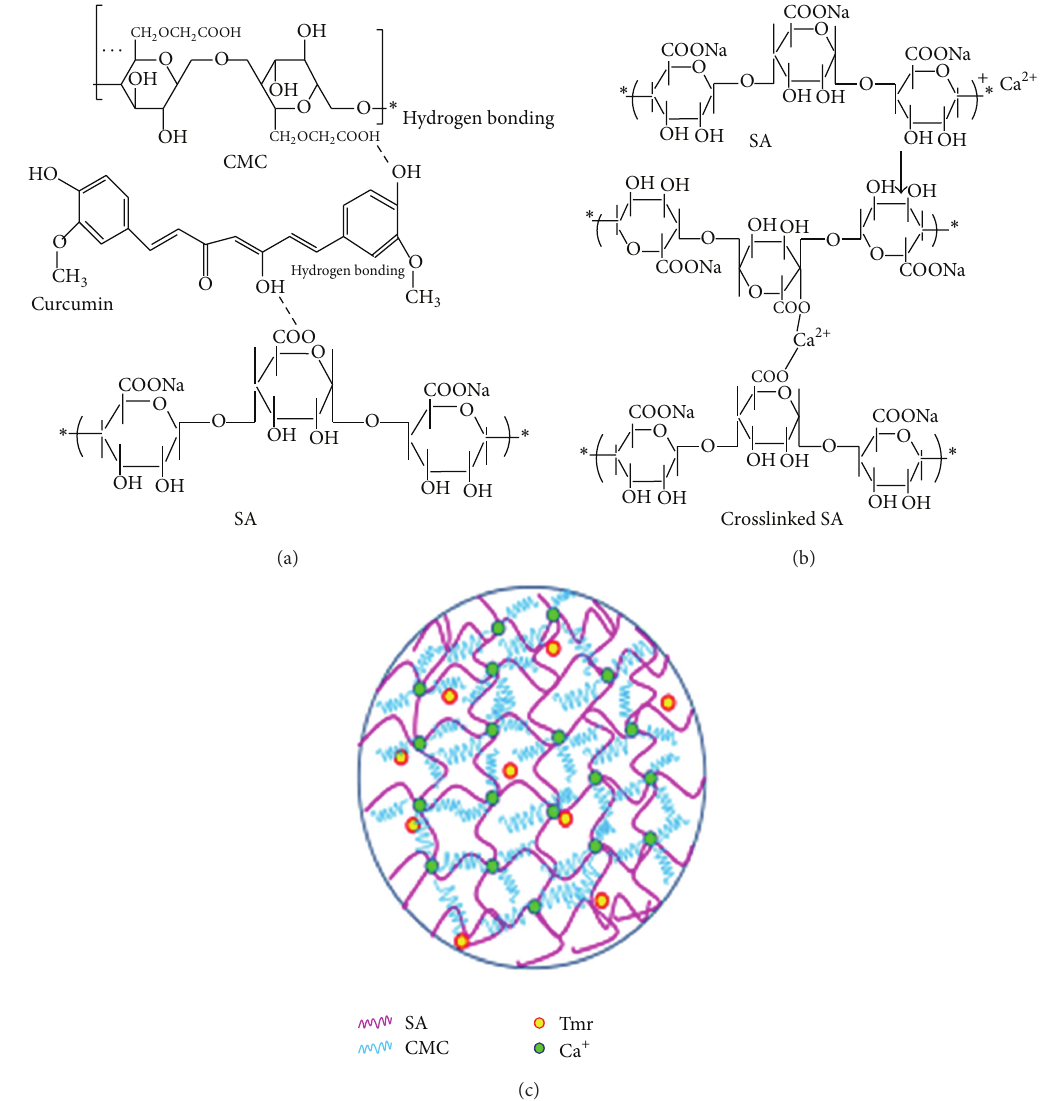
Figure 3: (a) Ionic crosslinking of CMC blend in SA/CMC blend with Ca 2+ , (b) ionic crosslinking of SA blend in SA/CMC blend with Ca 2+ , and (c) a conceptual schematic model of tmr nanoparticle.